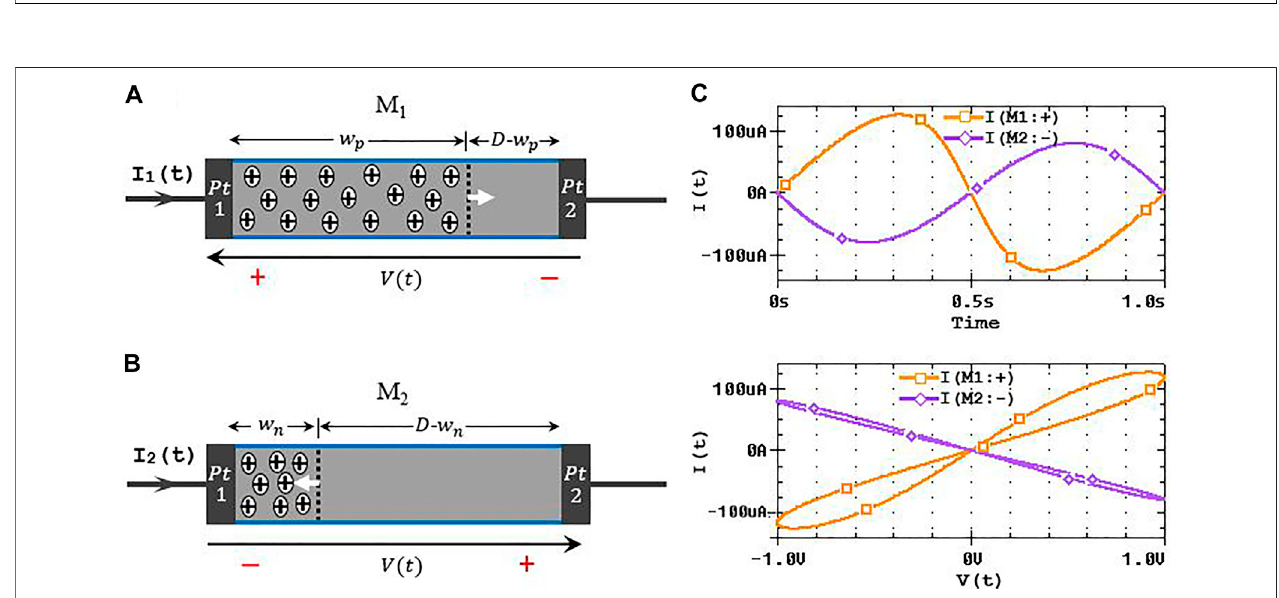
FIGURE 4 | Concentration of the dopants in relation to charge carrier mobility with respect to the polarity of the input signal. (A) Application of positive bias causes the expansion ofthedoped regionthroughthe bulkofthedevice; (B) application ofnegative biascausesthecontraction ofthe dopedregion(Joglekar and Wolf(2009)). Respectively, the overall process affects the device conducting channel widths w p and w n , and it gives the trend on how w approaches 0 or D , (C) the currents I 1 and I 2 through